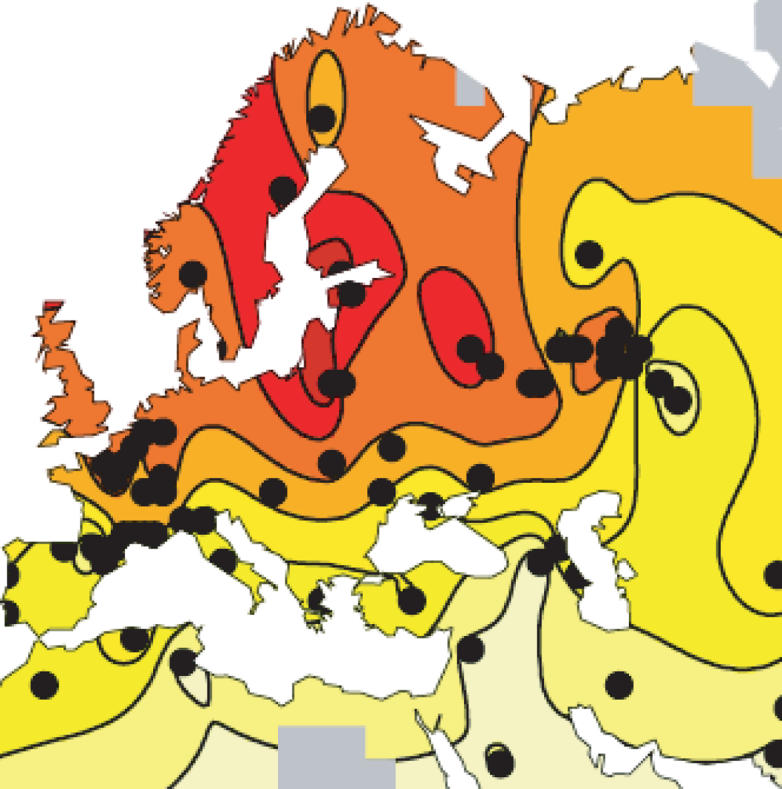
This contour map shows the European distribution of the CCR5 Δ32 variant, which was used to develop a method for studying the geographic spread of gene variants under positive selection